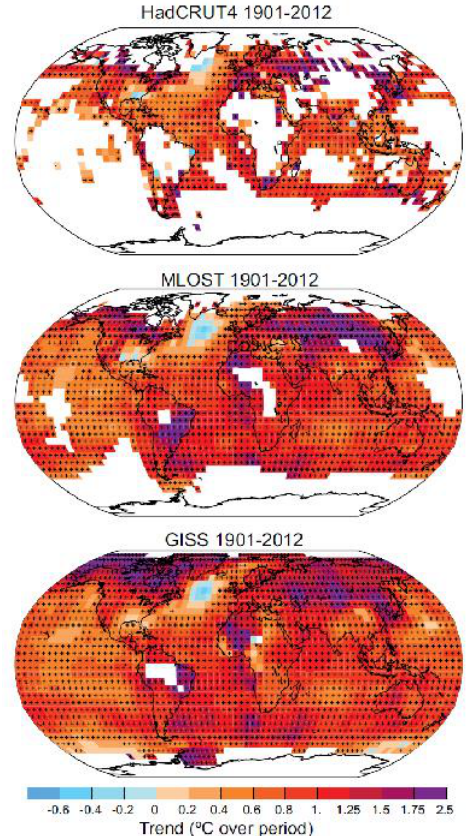
Figure 2. Surface Temperature Trends from three separate climate model data sets (HadCRUT4, MLOST, and GISS) for the period 1901 – 2012 (IPCC 2013) where white signifies